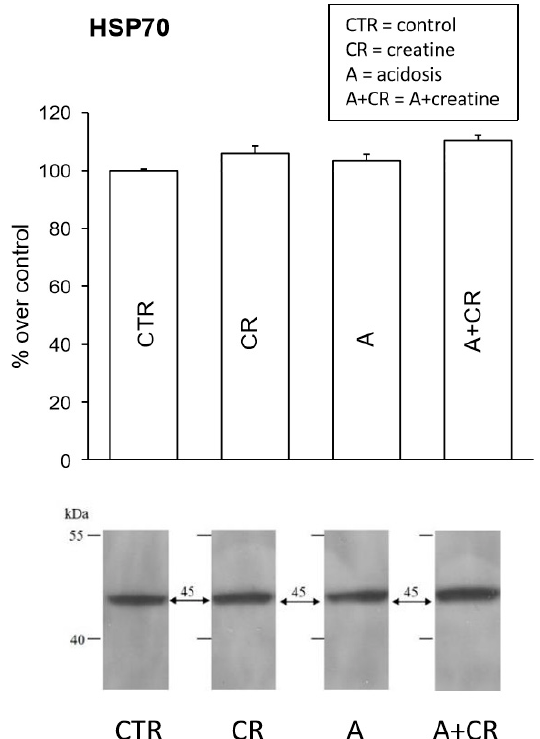
Figure 5. E ff ects of 11 d administration of 20 mM creatine on HSP70 expression in jejunal mucosal homogenates under control conditions and chronic acidosis. Western blot analysis for HSP 70 was performed on jejunum total proteins and was carried out on 4 experiments. Densitometric analysis of the bands did not reveal significant statistical di ff erences in the intensity of the signals.